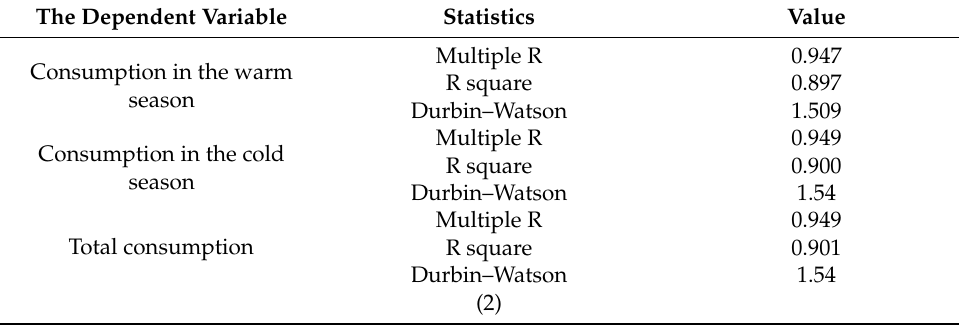
Figure 7. Correlation diagram of water consumption with other significant factors: ( a ) building over 30 years old; ( b ) deteriorated area; ( c ) average of the residential units; ( d ) population density. Table 6. Analytical statistics of linear regression of water consumption.